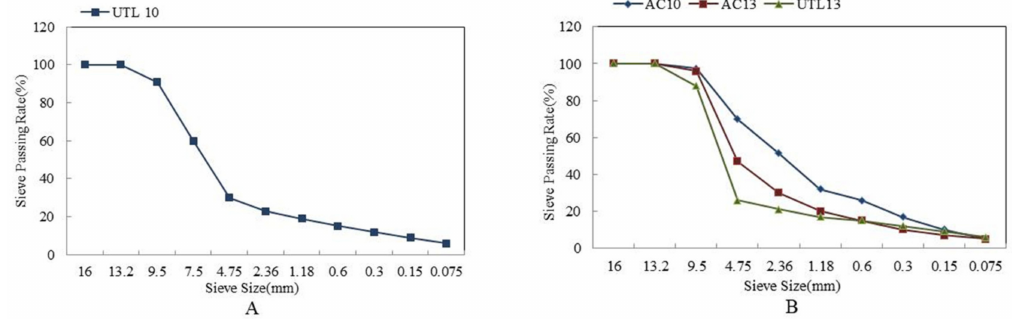
Figure 1. The gradation curves of di ff erent asphalt mixtures: ( A ) UTL10; ( B ) UTL13, AC13 and